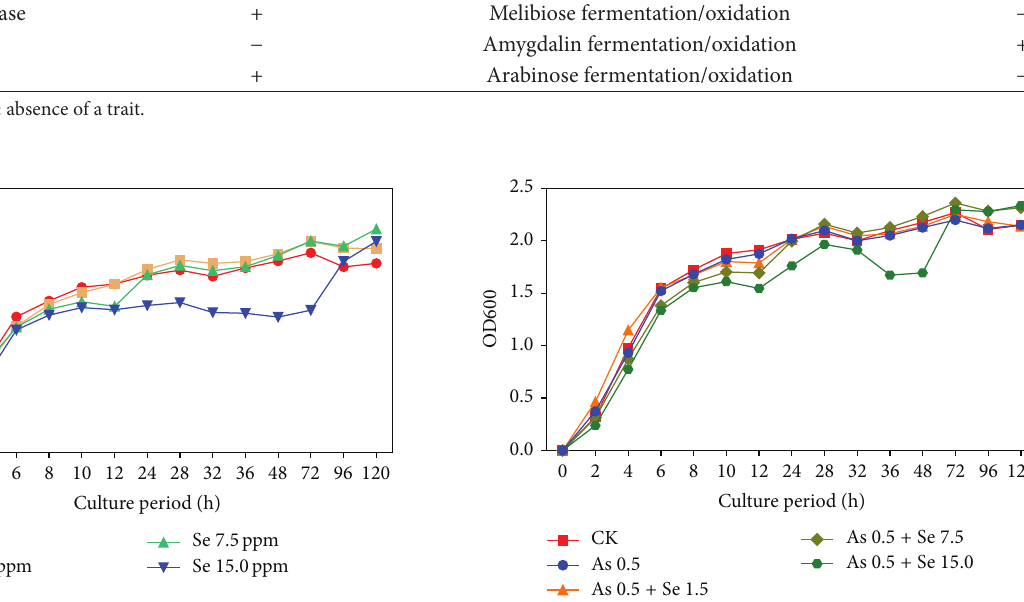
Figure 4: Growth curves of isolated strain in different Se medium. CK: growth in the culture without selenite; Se 1.5: grow in the culture with 1.5 mgSeL −1 ; Se 7.5: grow in the culture with 7.5mg SeL −1 ; Se15.0: grow in the culture with 15mg SeL −1 ( 𝑛 = 5 ).